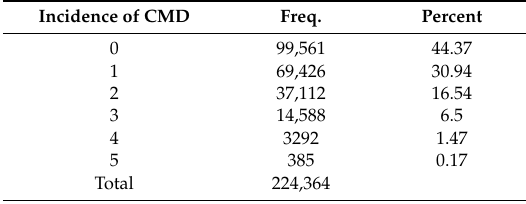
Table A1. CMD (frequency and percentages).